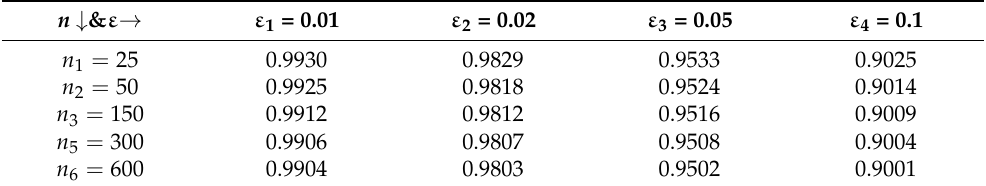
Table 13. Empirical levels and corresponding theoretical levels ( ε = 0.01, 0.02, 0.05, 0.1) and N =